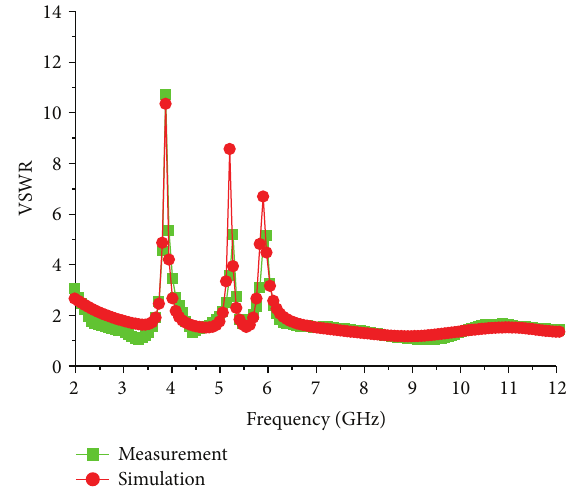
Figure 4: Comparison of simulated and measured VSWR of the proposed